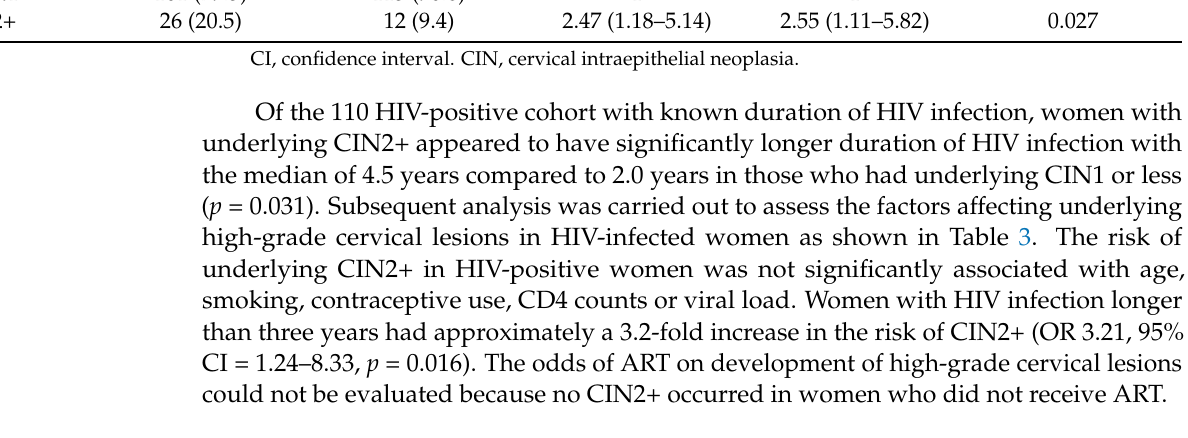
Table 3. Risk of underlying CIN2+ in women with HIV